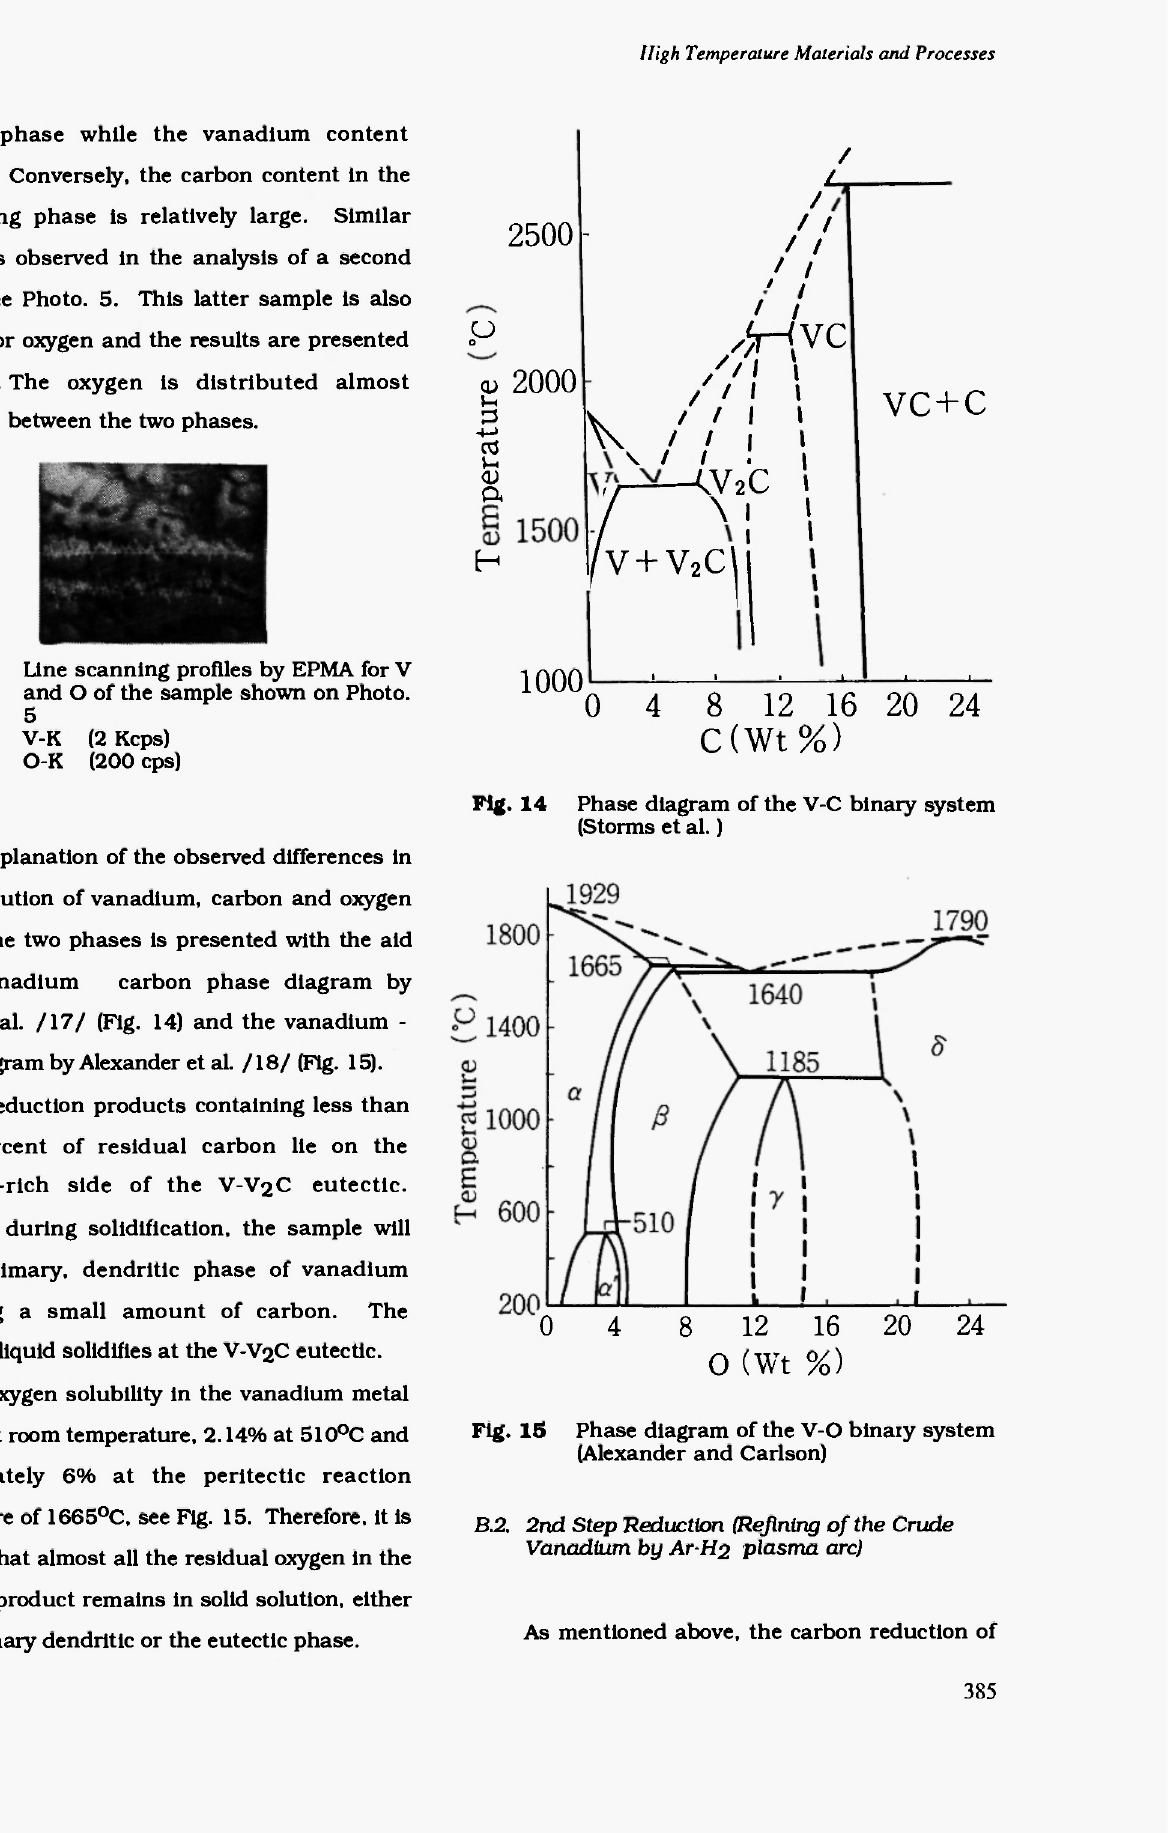
Fig. 14 Phase diagram of the V-C binary system (Storms et al.)